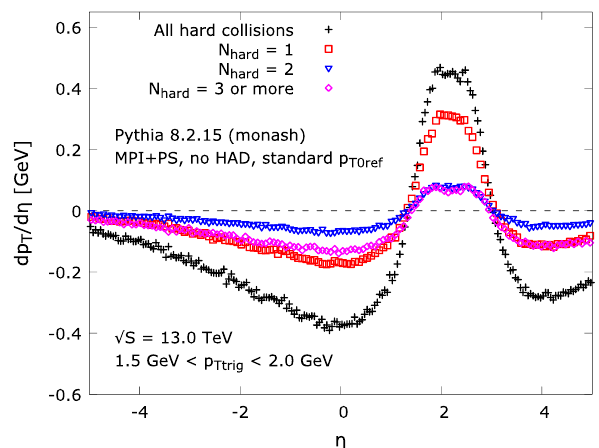
(cid:5) (cid:6) Fig. 13 p rec decomposed into contributions from subsequent (in p T ) T hard collisions with N hard = 1, 2 and 3 or more. The grouping into hard subsystems was done without hadronization